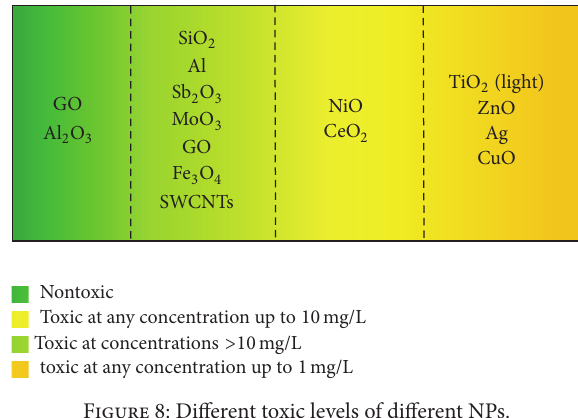
Figure 8: Different toxic levels of different